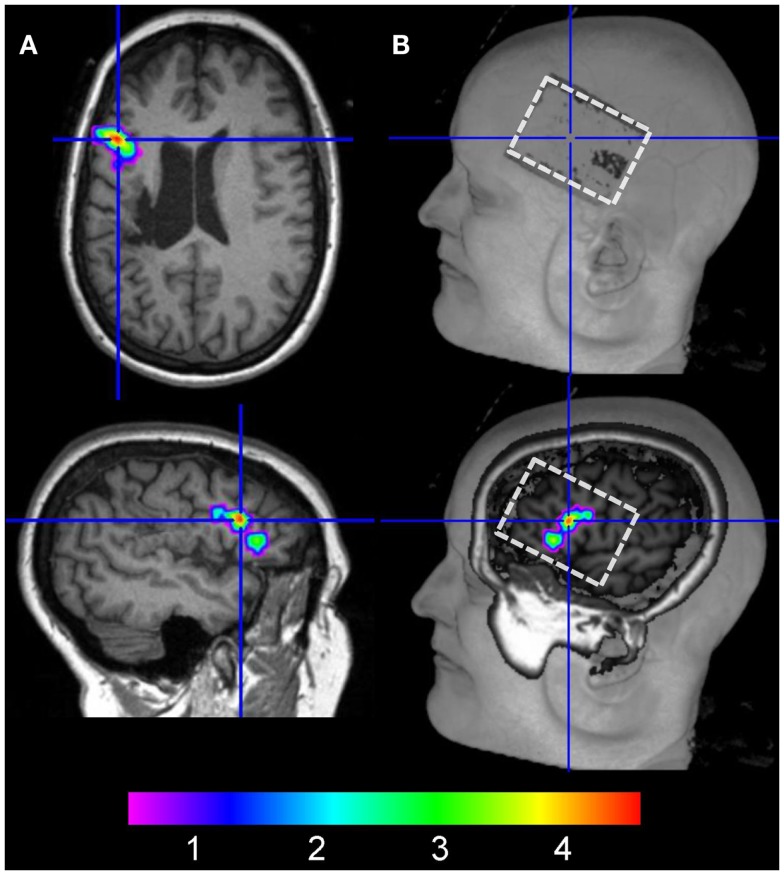
(A) The left column illustrates the location of peak activity in the left inferior frontal gyrus during the baseline fMRI session in native space (crosshair on axial and sagittal slices). (B) shows the location of the electrode on the scalp on the co-registered structural image of the patient acquired during anodal-tDCS (upper right image, white box). The lower right panel shows a more medial view of the same image with peak activity during the baseline scan overlaid.